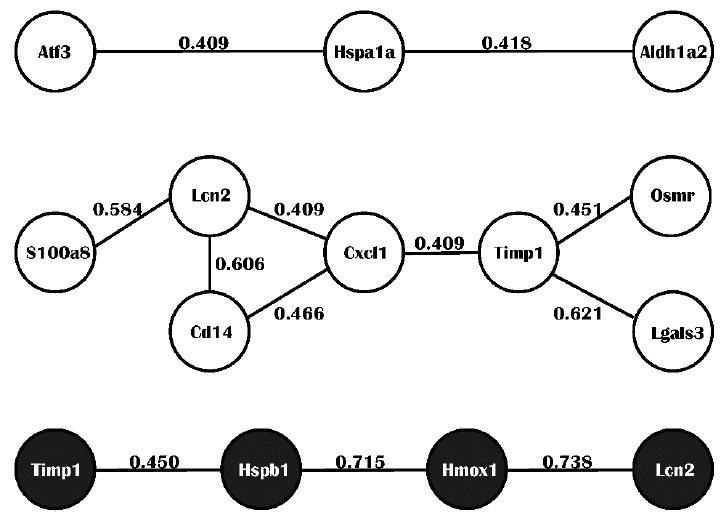
Figure 2. Protein–protein interaction (PPI) network. The confidence scores are marked in the line of interaction. (White: Mus musculus ; Black: Rattus norvegicus ).